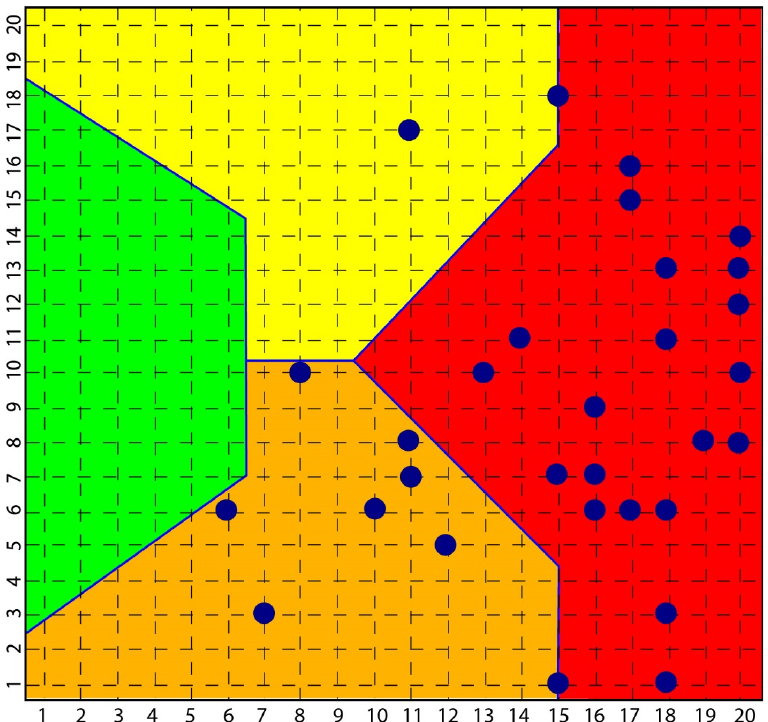
Figure 2. Distribution of scleroderma subjects in SOM. The figure shows how all subjects [35] with scleroderma are distributed among the yellow, orange and red area and none in the green area that classified normal subjects.